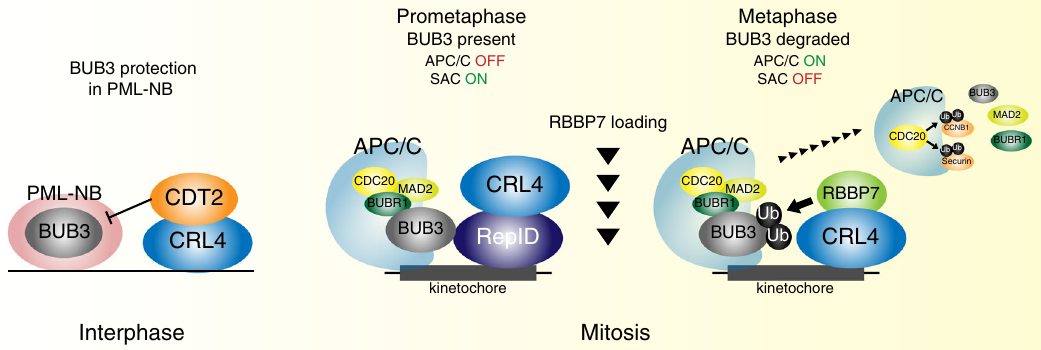
Fig. 7 Schematic model. RepID (structural DCAF) brings CRL4 on chromatin during interphase. BUB3 is localized to PML-NB, which protects BUB3 from degradation by CRL4 CDT2 . In RepID-de fi cient cells, BUB3 degradation is compromised even when PML-NB levels are decreased because chromatin-bound CRL4 are low. During mitosis, RepID recruits CRL4 on chromosome and binds to the kinetochore-localizing BUB3. While RepID is dissociated from CRL4, mitotic spindle-localizing RBBP7 (catalytic DCAF) is incorporated into CRL4 during metaphase. CRL4 RBBP7 -dependent degradation of BUB3 promotes dissociation of SAC, resulting in CDC20 – APC/C interaction and anaphase initiation. RepID-de fi cient cells exhibit no changes in function, expression, or localization of RBBP7 and BUB3. Prolonged metaphase – anaphase transition by defective BUB3 degradation in RepID-de fi cient cells is due to a decrease of CRL4 on mitotic chromosomes, leading to increased sensitivity to PTX